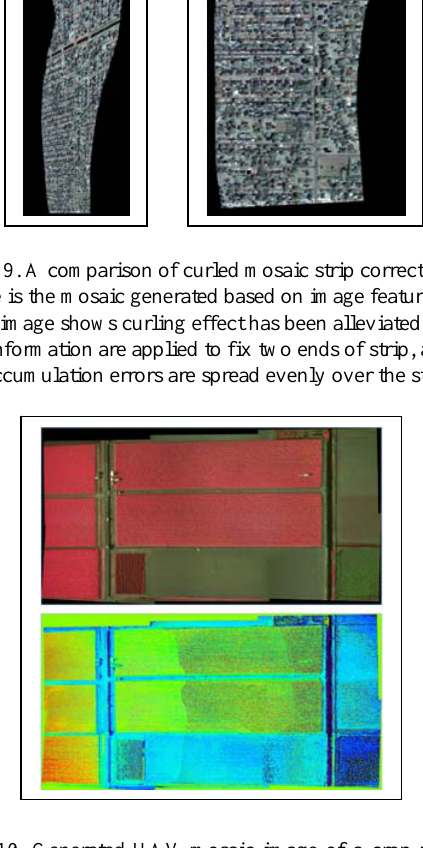
Figure 10. Generated UAV mosaic image of a crop field. The upper image is in false colour and the lower image is generated NDVI